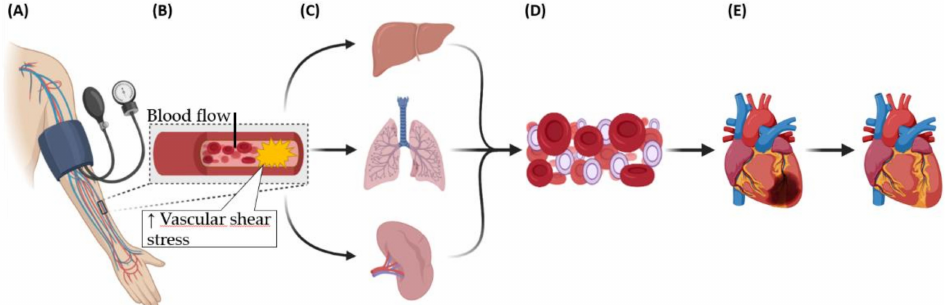
Figure 1. Schematic overview of remote ischemic preconditioning (RIPC) stimulating exosome production resulting in myocardial protection. ( A ) Repeated cycles of ischemia reperfusion induced by blood pressure cuff inflation at the arm. ( B ) RIPC induces shear stress in the vasculature. ( C ) The shear stress stimulates the humoral system to release cardiopro- tective factors into the blood. ( D ) Cardioprotective factors are carried by the blood. ( E ) Cardioprotective factors reach the myocardium and activate cardioprotective signaling pathways that lead to reduced tissue damage and improved